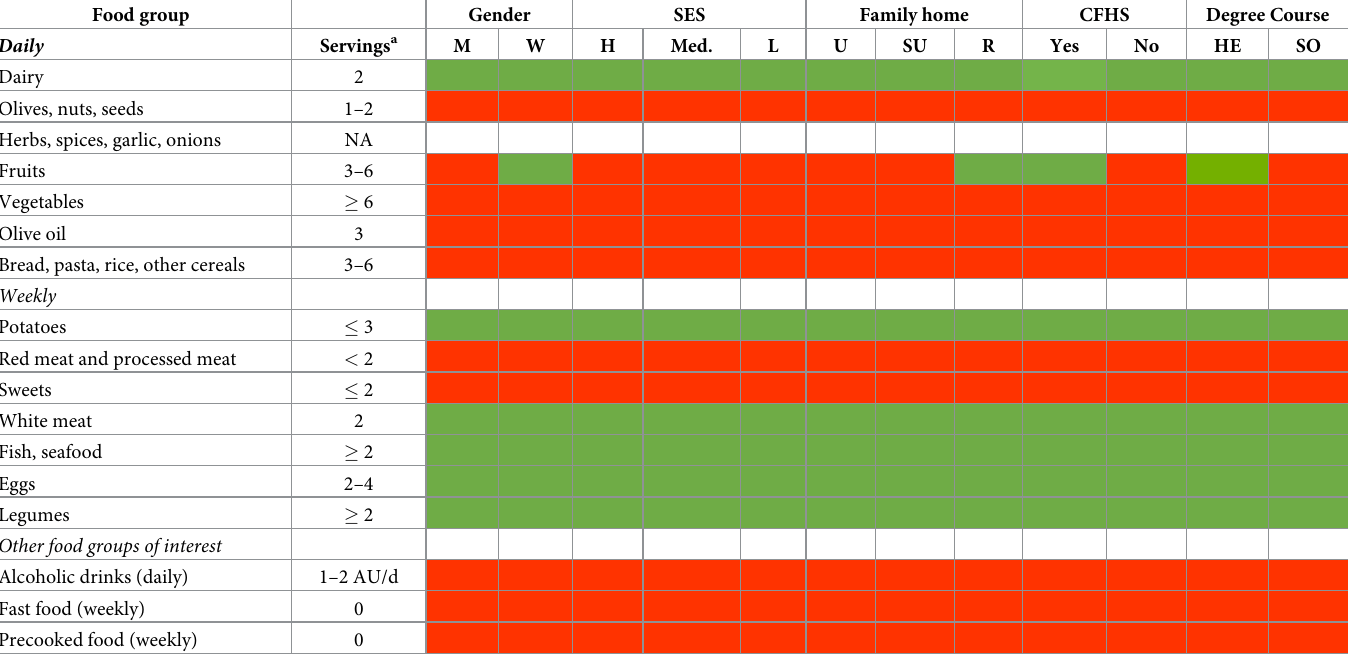
Table 7. Compliance with the recommendations of the Mediterranean diet pyramid ( n =